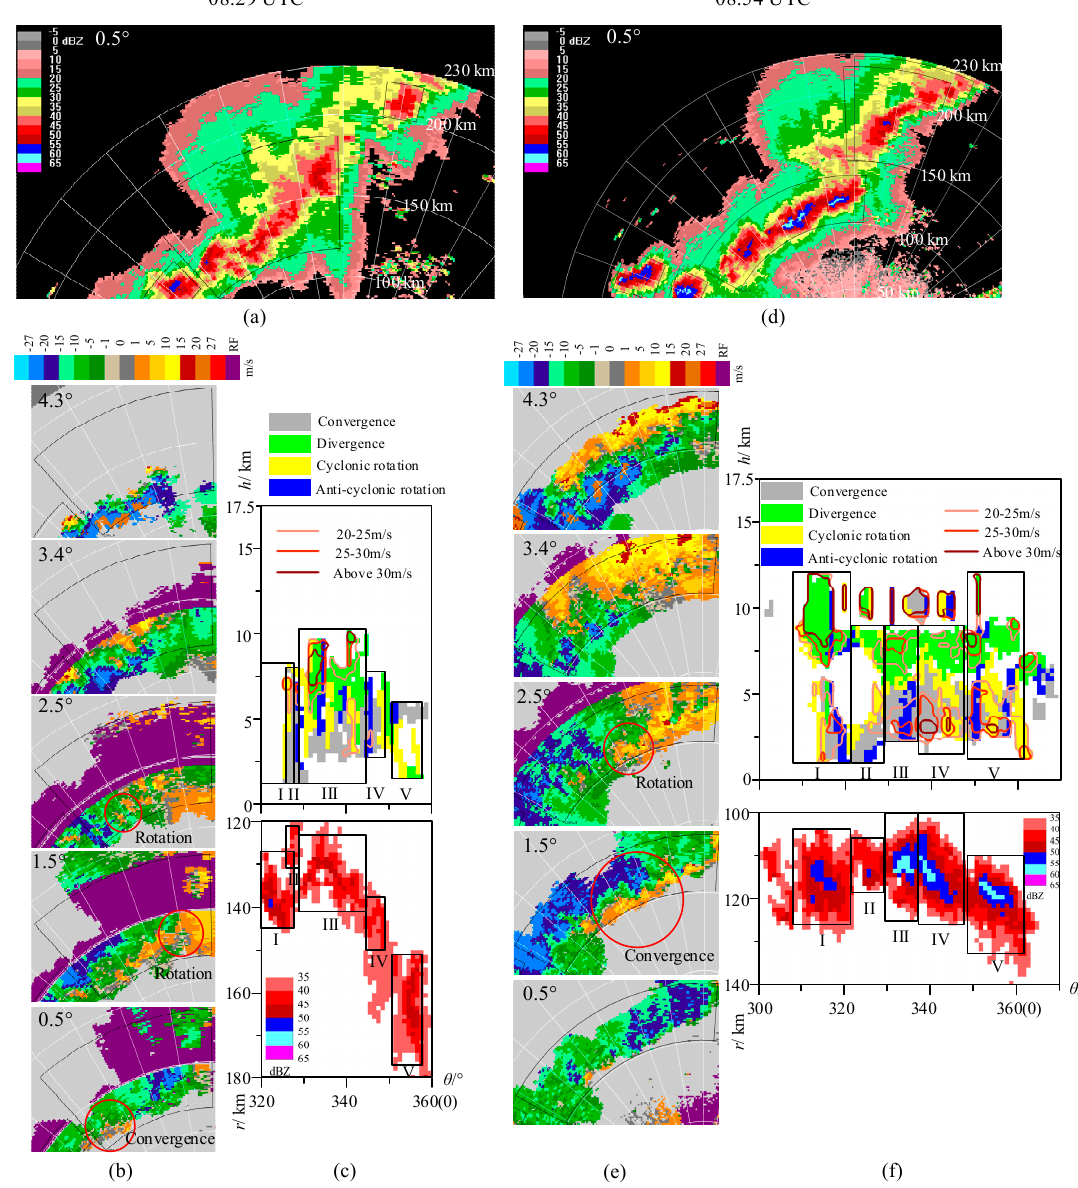
Figure 8. The airflow field structures of the squall line (13 June 2005) at 08:29 and 08:54 UTC: ( a ) The reflectivity map at the elevation angle of 0.5° (08:29 UTC), ( b ) radial velocity maps (08:29 UTC), ( c ) the PMAFSTI and the corresponding composite reflectivity map in the θ - r rectangular coordinate system of the study region (08:29 UTC), ( d ) the reflectivity map at the elevation angle of 0.5° (08:54 UTC), ( e ) radial velocity maps (08:54 UTC), and ( f ) the PMAFSTI and the corresponding composite reflectivity map in the θ - r rectangular coordinate system of the study region (08:54 UTC).